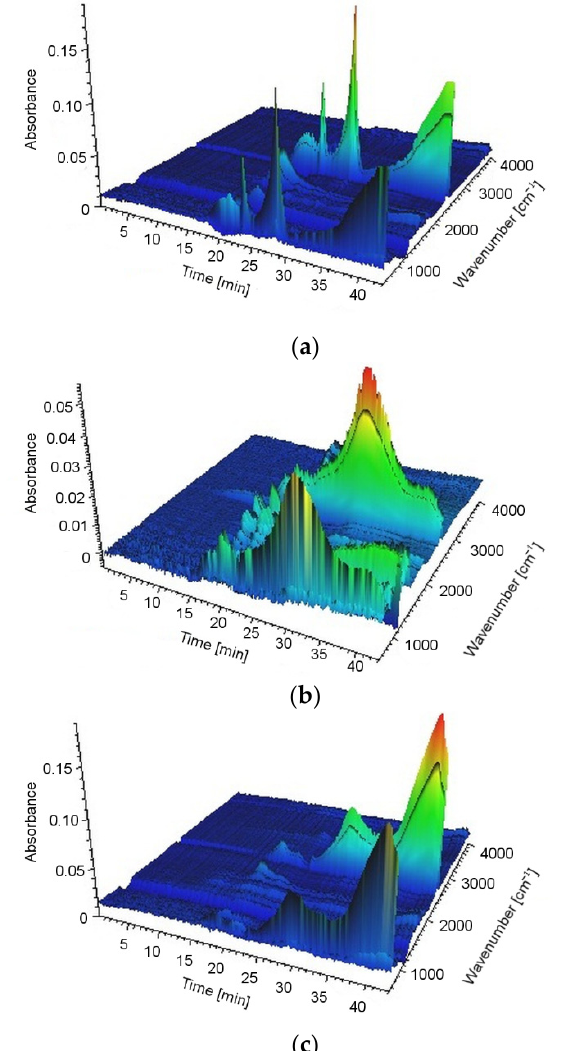
Figure 10. The 3D-IR spectra of UP ( a ), UP/30APP ( b ) and UP/30LHP ( c ).